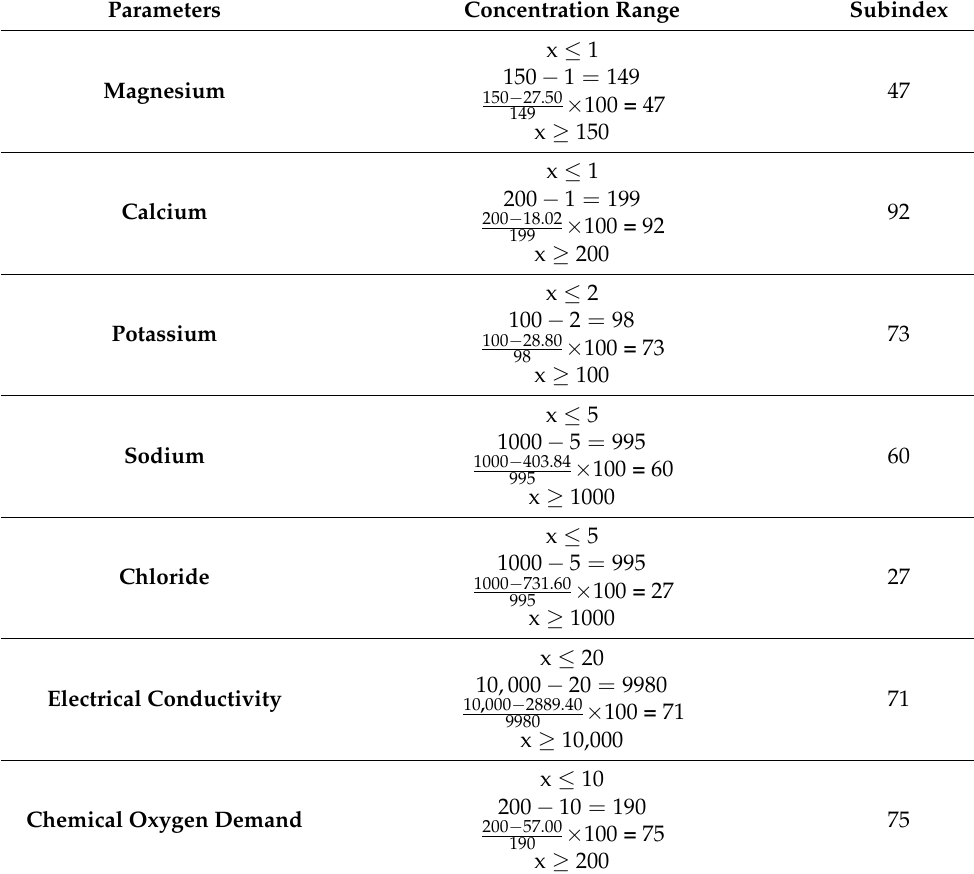
Table 9. Subindex value of parameters using proportional